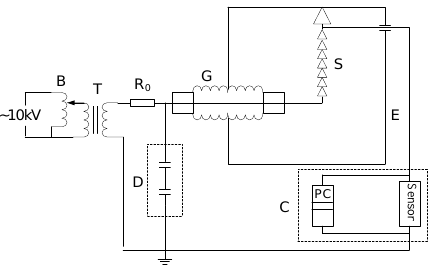
Figure 1. Schematic diagram of the alternating current (AC) test circuit, B—the voltage regulator, T—the test transformer, R 0 —the protective resistance, G—the wall bushing, D—the capacitive voltage divider, E—the climate chamber, C—the leakage current measurement system, and S—the insulator string sample.